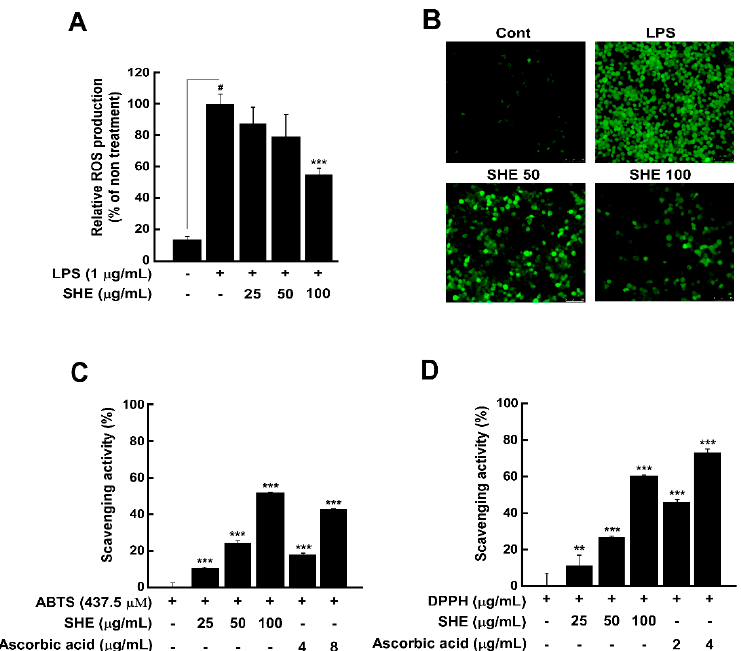
Figure 4. Radical scavenger effects and antioxidant of Soroseris hirsuta extract (SHE) after lipopolysaccharide (LPS) treatment in RAW 264.7 cells. ( A ) Reactive oxygen species (ROS) were induced in RAW 264.7 cells due to LPS treatment (1 μ g/mL) for 24 h. The reduction of ROS production due to the SHE pretreatment was carried out by measuring the amount of fluorescence expression using 2 ′ ,7 ′ -dichlorofluorescein diacetate (DCFH-DA) analysis. ( B ) The measurement of ROS inhibition was performed using a fluorescence microscope to verify the fluorescence emitted by DCFH-DA and was performed in the same experimental method as ( A ). ( C , D ) SHE scavenging activity of DPPH and ABTS radicals. A series of processes was carried out as described in the Materials and Methods section. # p < 0.001, ** p < 0.01 and *** p < 0.001.